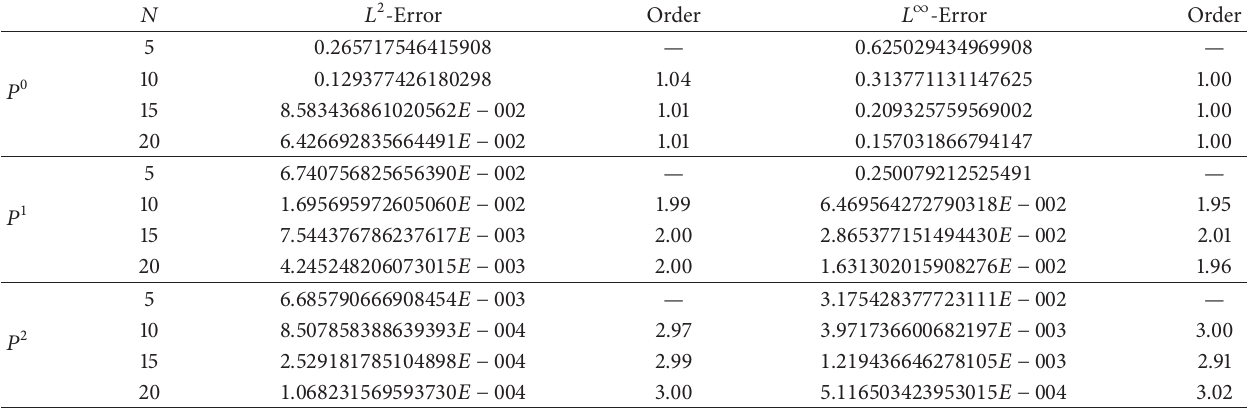
Table 5: Spatial accuracy test for the fractional order equation with the forcing term (42). 𝛼 = 0.5 , 𝑀 = 10 4 , 𝑇 = 1 . 𝑁 𝐿 2 -Error Order 𝐿 ∞ -Error Order 5 — 𝑃 0